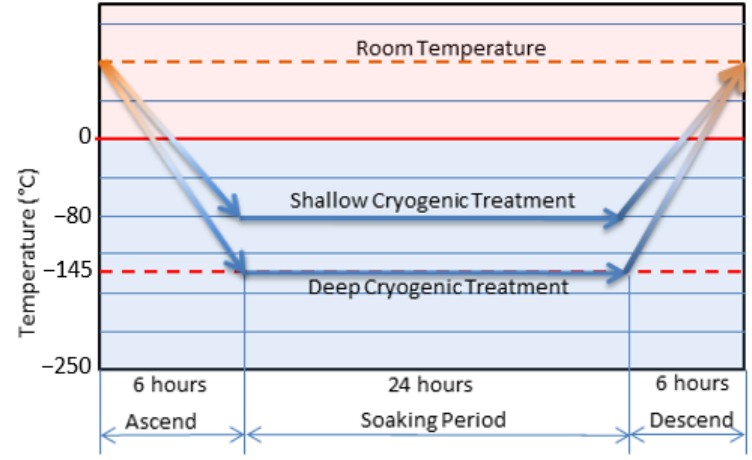
Figure 1. Cryogenic treatment schedule.